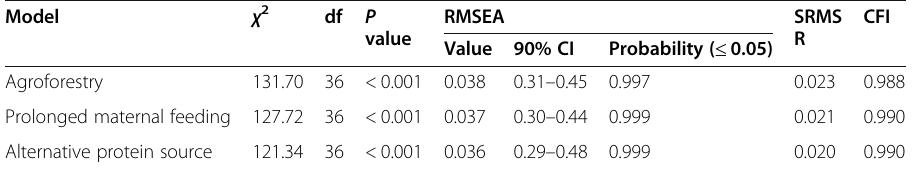
Table 13 Pooled SEM model fit indices Model